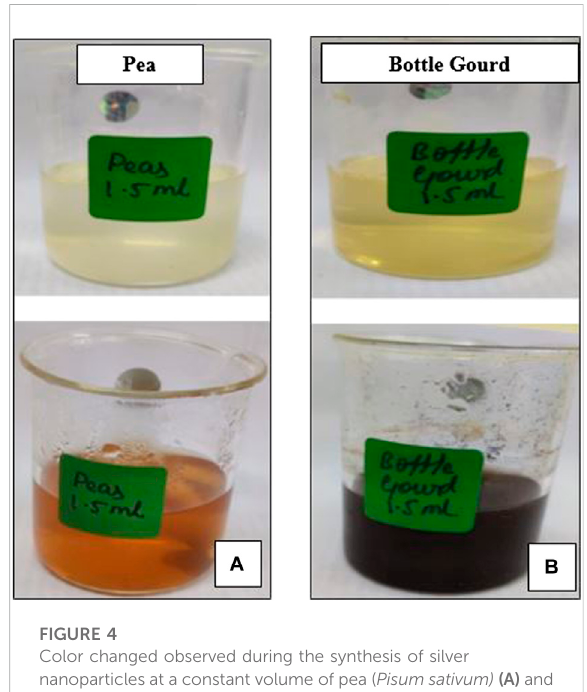
FIGURE 4 Color changed observed during the synthesis of silver nanoparticles at a constant volume of pea ( Pisum sativum) (A) and bottle gourd peels ( Lagenaria siceraria) (B) extract with the silver nitrate